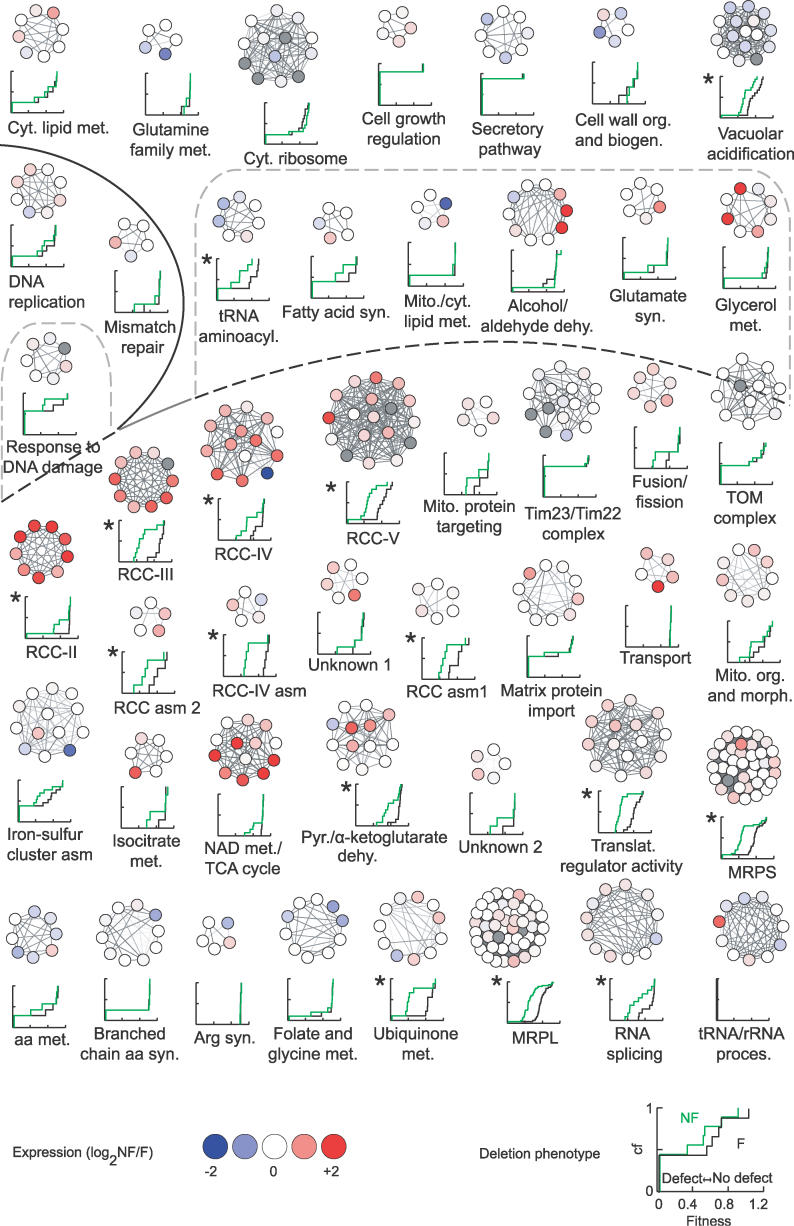
Mutant Phenotype and RegulationCumulative frequency of the fitness scores of single gene deletion mutants on NF, green line, and F, black line, conditions are plotted for each functional module. Genes annotated in SGD as inviable were assigned a fitness value of zero. As an example, the graph depicted in the legend shows that close to half of the genes are essential (lower half of y-axis), the other half differ in their quantitative deletion phenotypes and range from poor fitness (severe growth defect) to high fitness (no growth defect). On the x-axis, the offset of the curves of different color shows that the distribution of growth defects of the non-essential genes differs between the two growth conditions, and in this case shows that more severe defects were observed under NF than F conditions. This designates a mitochondrial specific phenotype. The one-sided paired Wilcoxon rank test was used to assess whether the deletion mutant strains for genes of a module have a significantly impaired fitness under NF versus F conditions. Significance is indicated by star (p < 0.05). In the modules, node color indicates the mRNA expression level difference between growth on NF (YPL, SCL, and YPE) versus F (YPD and SCD) conditions (red gradient, higher expression; and blue gradient, reduced expression during NF growth). A stringent criterion was applied to calculate a single expression value for the difference between NF and F growth: genes with a consistent direction of the three ratios were assigned the least-fold difference; genes that show no differential regulation or show fold ratios opposite in direction between any two conditions were assigned a fold ratio of zero. Gray nodes had no expression measurements. The identity of single proteins can be found in Figure S6. cf, cumulative frequency.